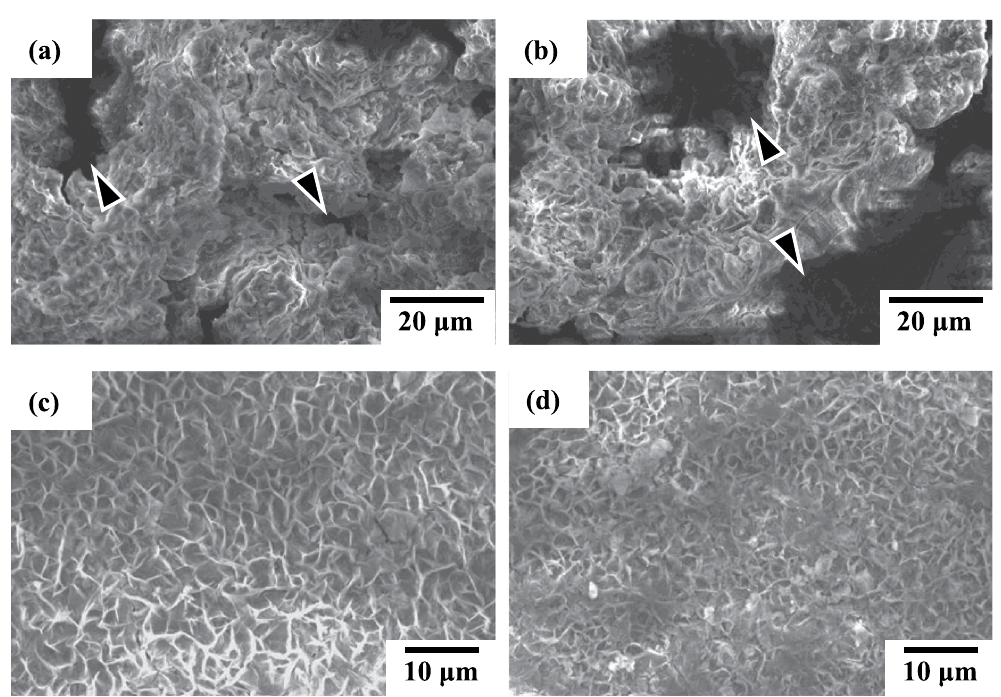
Figure 8. SEM surface morphologies of the ( a ) AZ61 Mg alloy, ( b ) AZ61-AP, ( c ) AP-HT, and ( d ) HT-SAM after potentiodynamic polarization